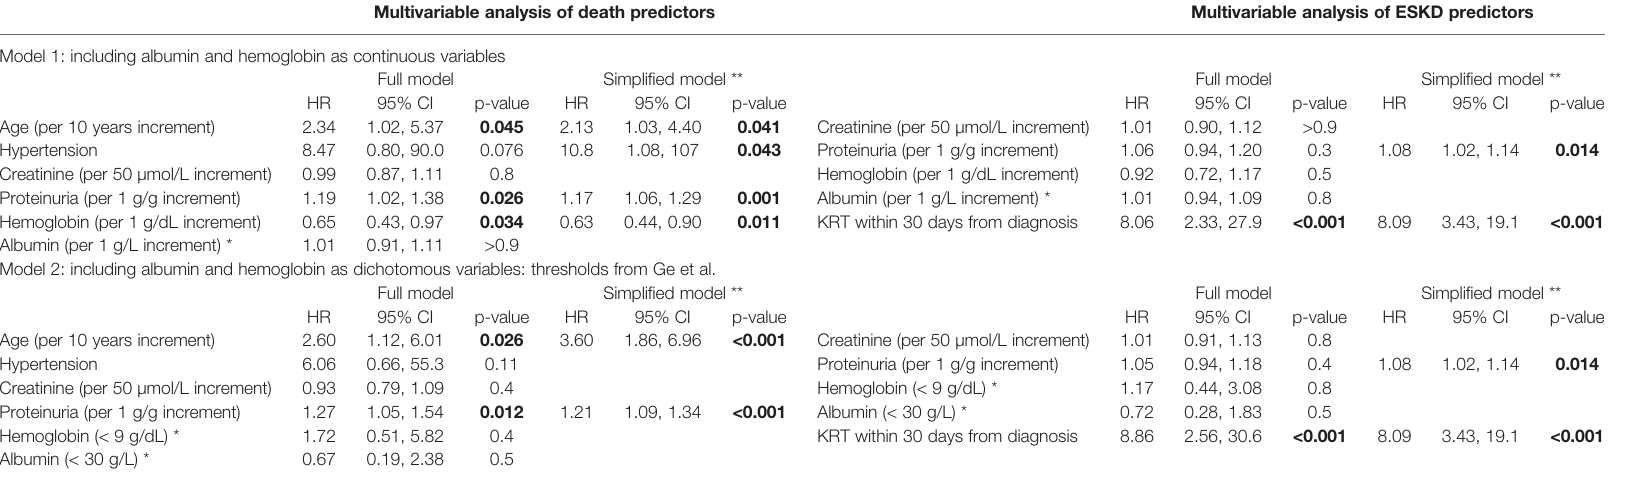
TABLE 1 | 5-years censured Cox Multivariable analysis of patient survival (death) or renal survival